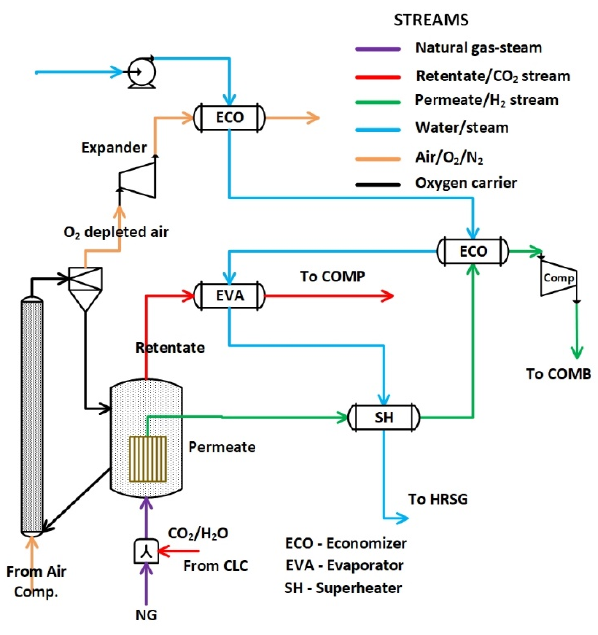
Figure 4. Schematic of case 2 (only the MA-CLR is shown).